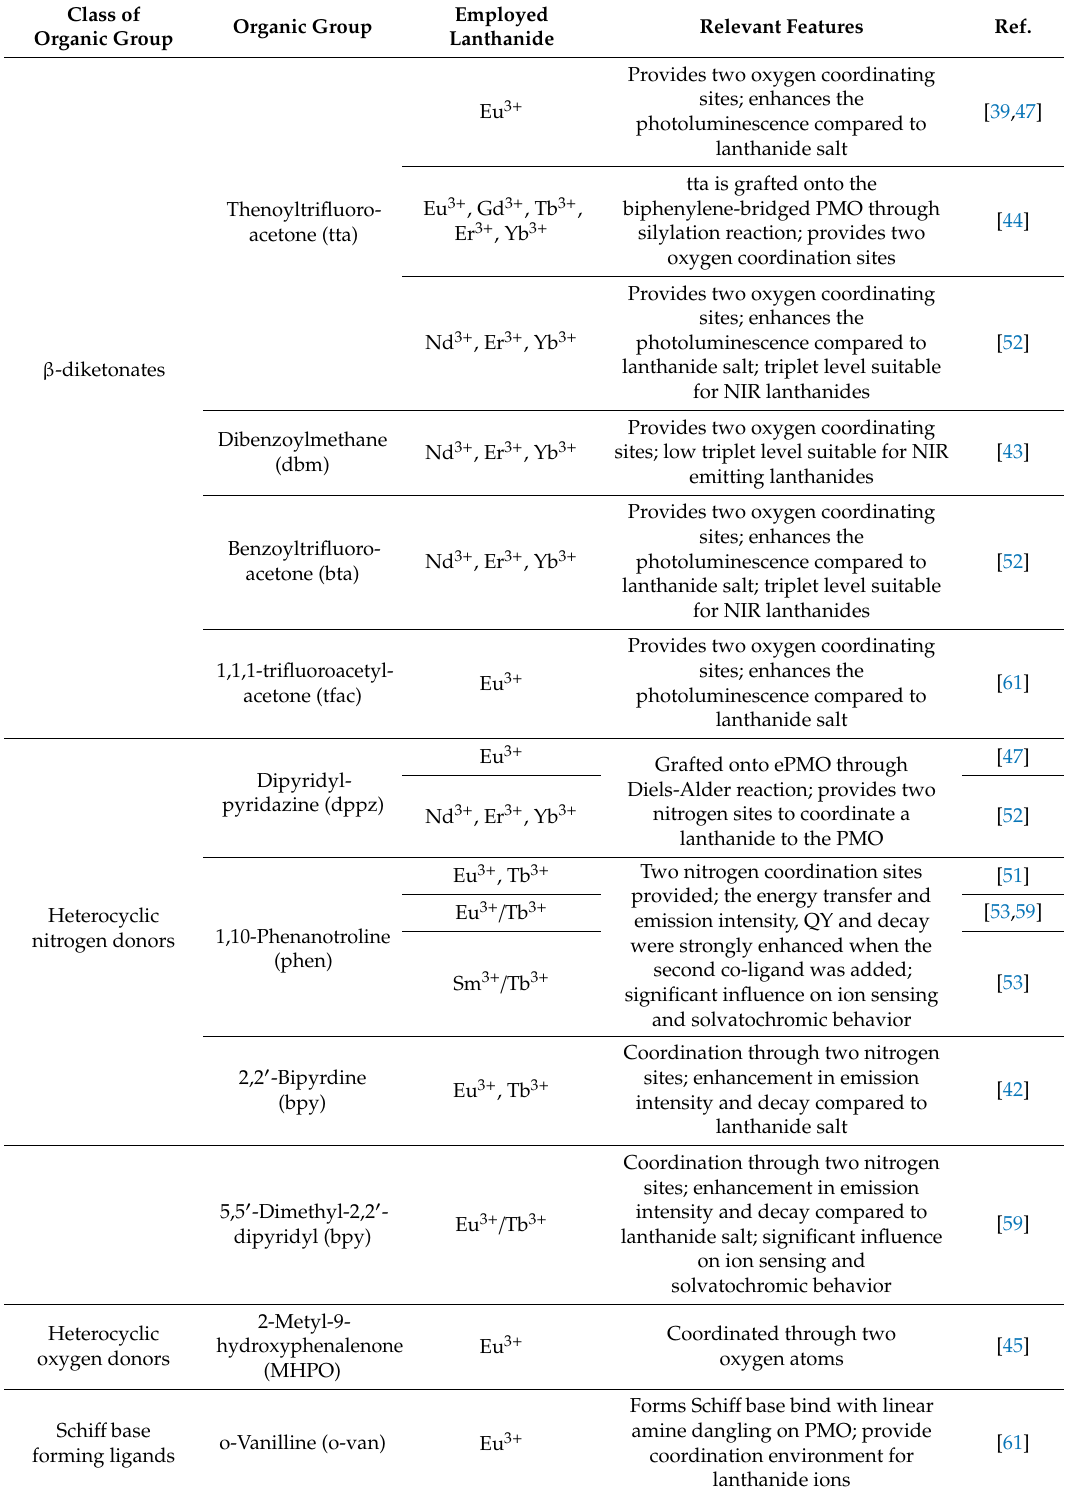
Table 3. Summary of the di ff erent organic moieties used to functionalize the